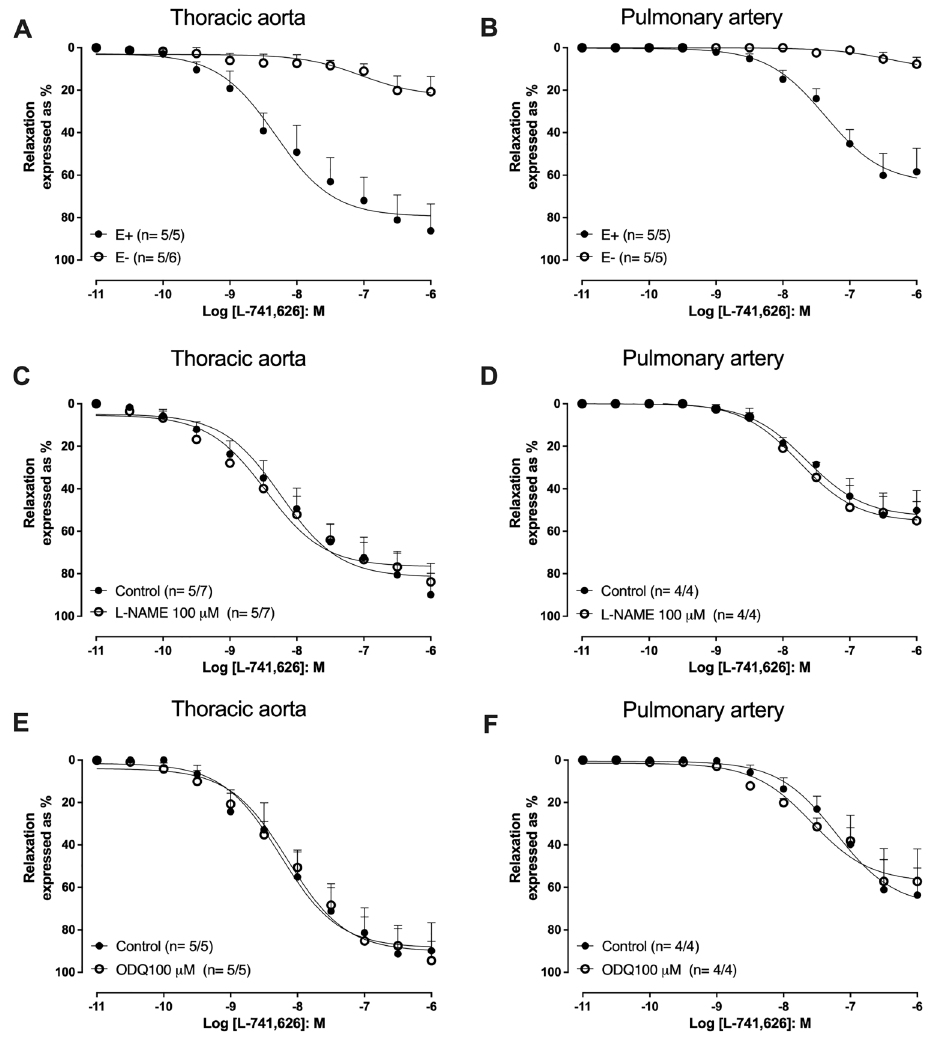
Figure 4. Relaxations induced by L-741,626 in U-46619 pre-contracted thoracic aorta and pulmonary artery rings. Panels A and B illustrate the effect of endothelium removal (E-) on the relaxations induced by L-742,626 on thoracic aorta (n=5/5) and pulmonary artery rings (n=5/5), respectively. Panels C and D show the effect of pre-incubation (30 min) of L-NAME (100 m M) on the relaxations induced by selective dopamine D 2 -receptor antagonist L-742,626 on thoracic aorta rings (n=5/7) and pulmonary artery rings (n=4/4), respectively. Panels E and F show the effect of pre-incubation (30 min) of ODQ (100 m M) on the relaxations induced by L-742,626 on thoracic aorta rings (n=5/5) and pulmonary artery rings (n=4/4), respectively. The number of experiments (n) is reported as x/y, where x represents the number of animals and y the number of rings